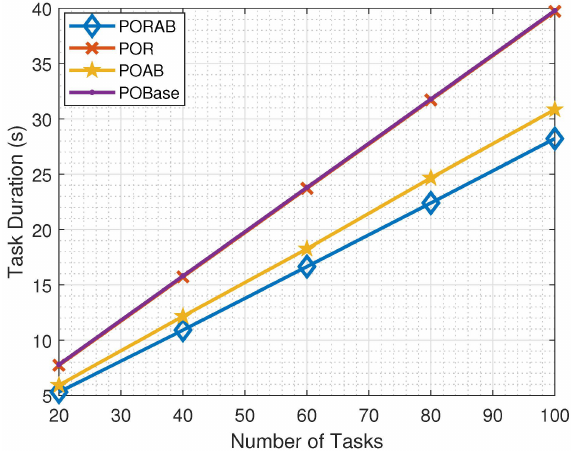
Figure 4. Variation of task computation time with the number of